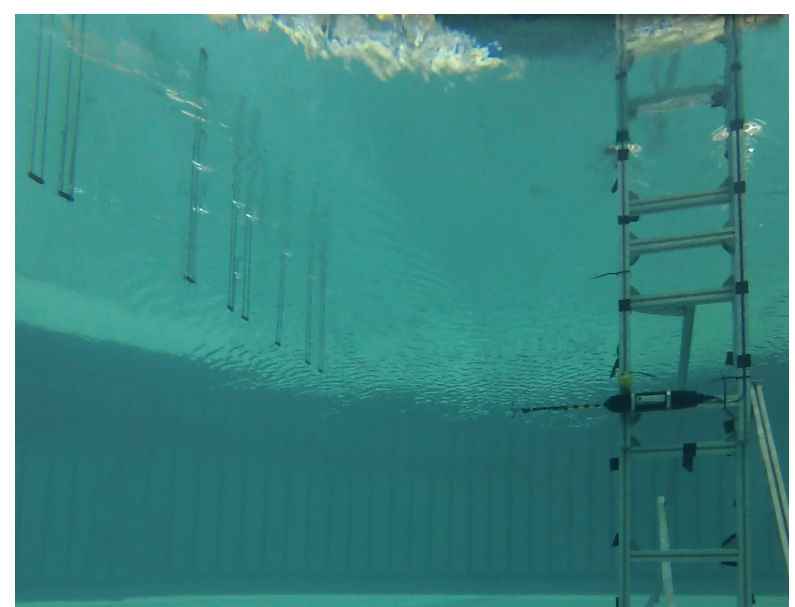
Figure 4. Under-water image of the test setup. Taken using a camera mounted to the tank